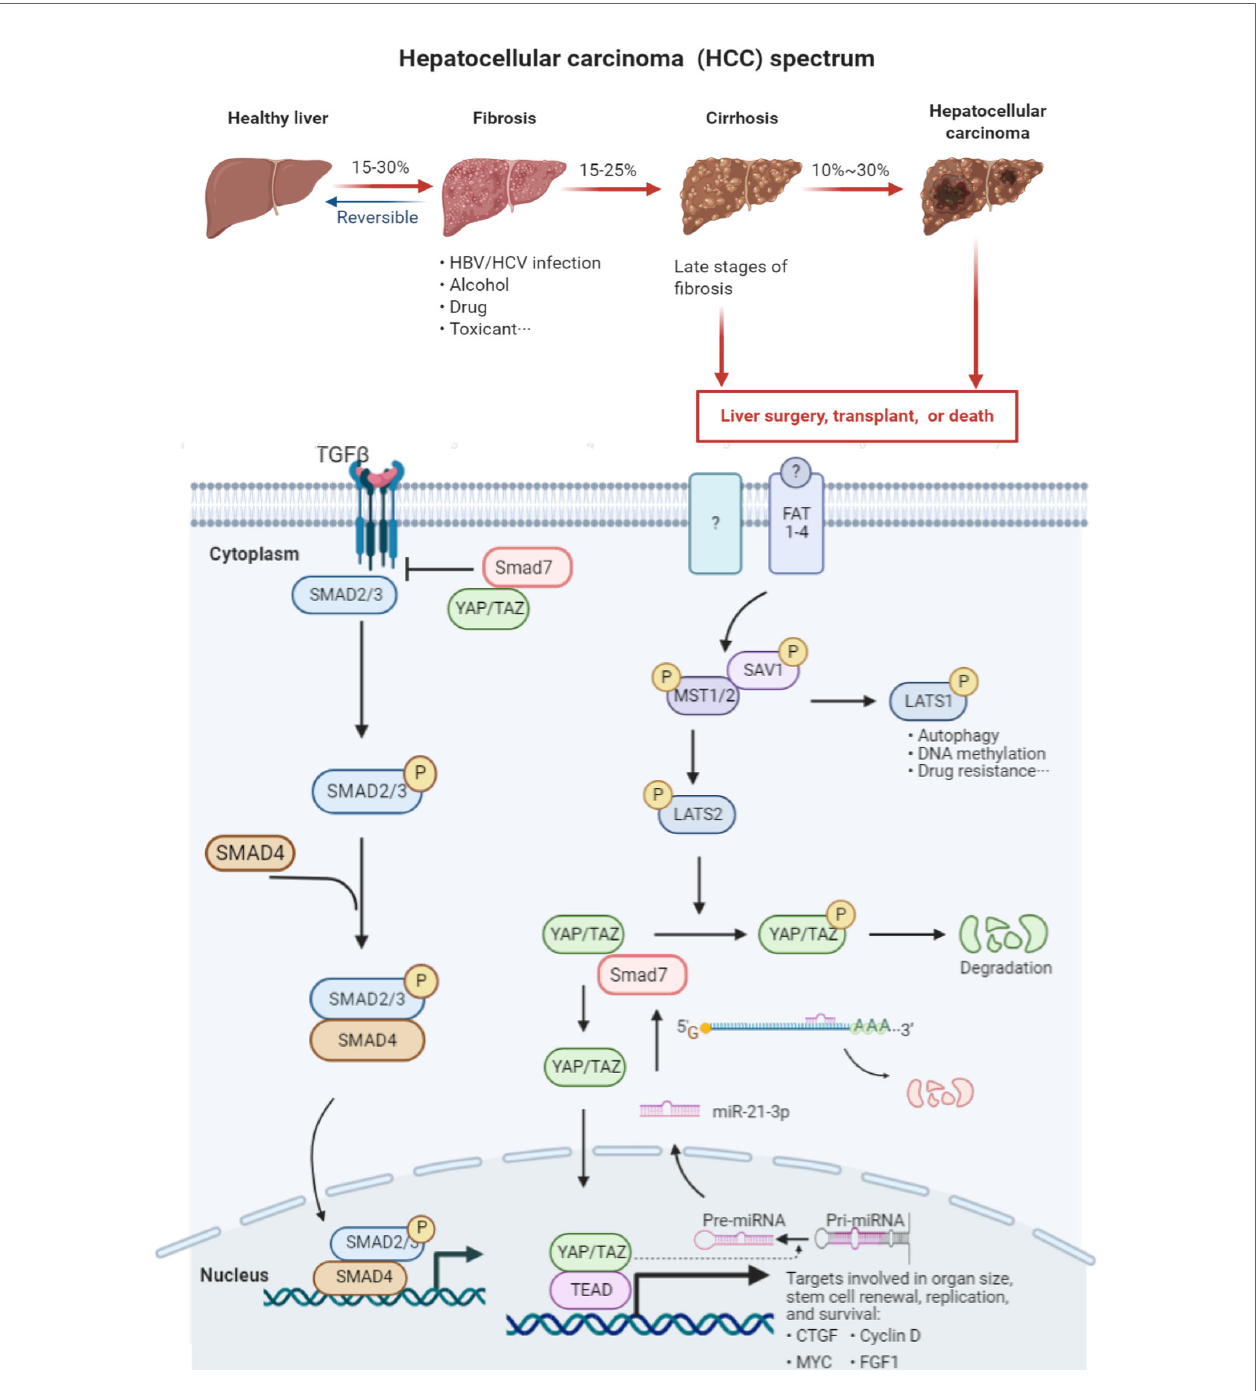
FIGURE 7 | Graph abstract HCC manifestation is typically preceded by hepatic fi brosis and cirrhosis. There are limited cures for patients suffering advanced liver cirrhosis and HCC. Dysfunction of the Hippo signaling and TGF-beta transduction pathways plays a vital role in the pathogenesis and course of this illness. YAP1 recruits SMAD7 to activated TGF- b receptor I (T b RI), hampering the formation of co-SMAD (SMAD2/3 and SMAD2/4) complexes. These SMAD complexes are thus unable to enter the nucleus to activate transcription of downstream effectors. SMAD7 serves as the negative regulator of the TGF- b signaling pathway. The Hippo signaling pathway is composed of a series of kinases including MST1/2, LATS1/2, and nuclear effector YAP1. Once the Hippo pathway is activated, LATS1/2 is phosphorylated by MST1/2. LATS1 is mainly involved in cell autophagy, DNA methylation and drug resistance. LATS2 phosphorylates YAP1, leading to its degradation. Overexpressed miR-21-3p directly silences SMAD7 expression by binding to its 3 ′ -UTR region, further impairing the linkage between SMAD7 and YAP1. The decreased stability of the SMAD7/YAP1 complex facilitates YAP1 translocation to the nucleus and results in the subsequent transcription of the downstream gene connective tissue growth factor